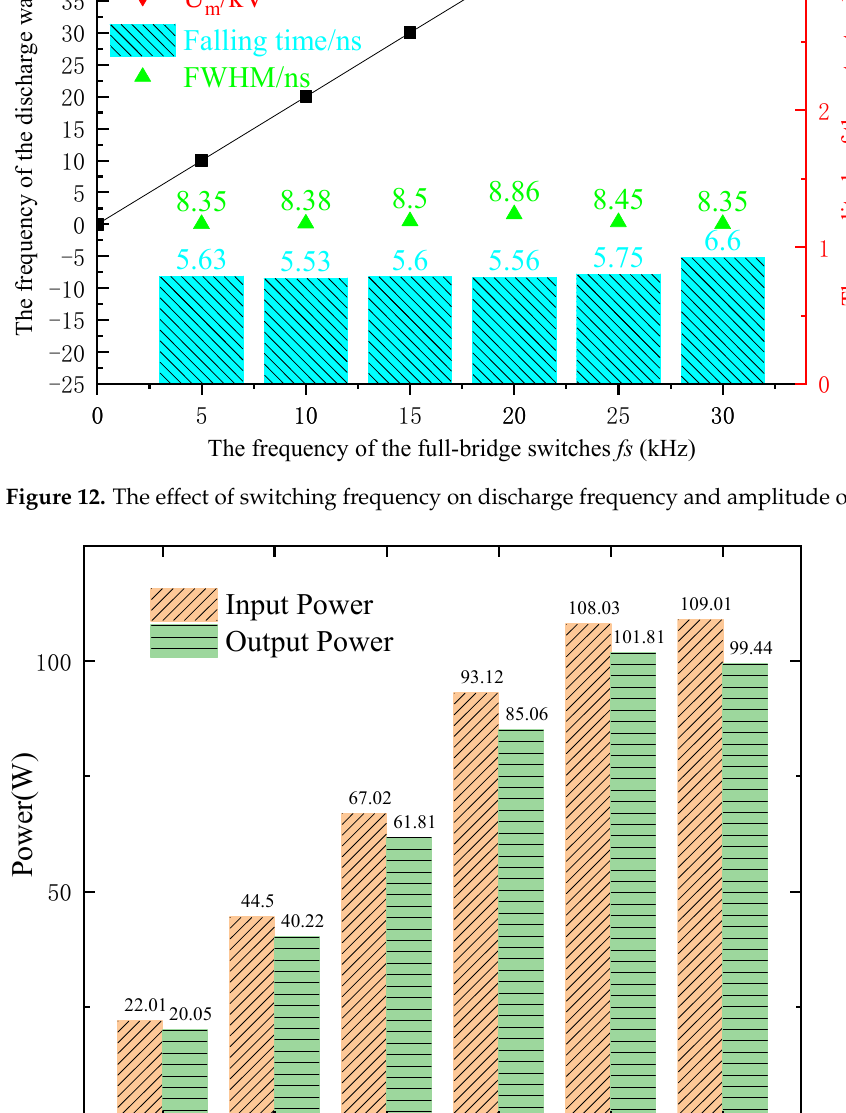
The frequency of output pulse f (kHz) Figure 14. The energy efficiency of the circuit at different output pulse frequencies. In fact, in addition to the energy efficiency used in this paper, some researchers also use voltage efficiency η voltage to compare the performance between circuits, as shown in References [19,20]. The equation of voltage efficiency is shown in Equation (23). The key parameters are summarized in Table 2. The new generator proposed in this paper signif- icantly improves the voltage efficiency of the circuit from 50% to 90%. Compared with the traditional structure, the number of BJTs required to achieve the 4 kV repetition output is significantly reduced to 16. In addition to substantially improving voltage efficiency, the proposed generator in this paper also achieves a high repetition frequency which is ad- justable from 10 to 60 kHz.